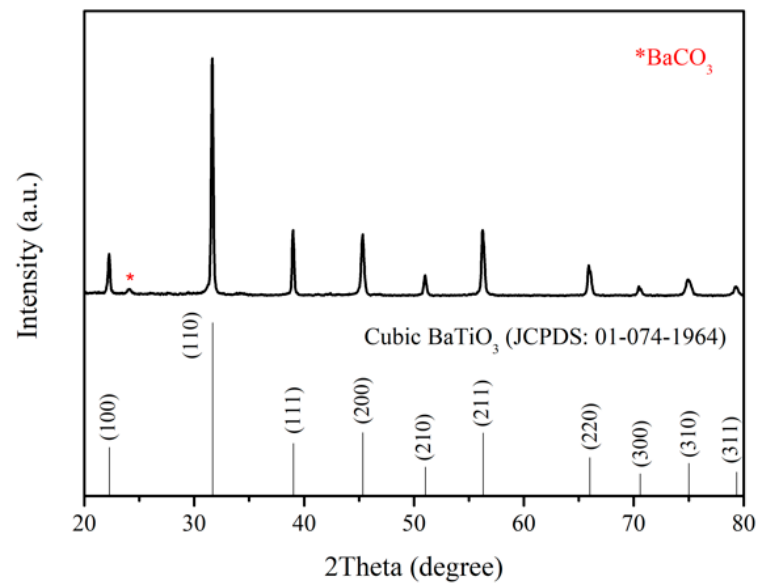
Figure 1. XRD patterns of the BaTiO 3 powder synthesized using the solution combustion method.